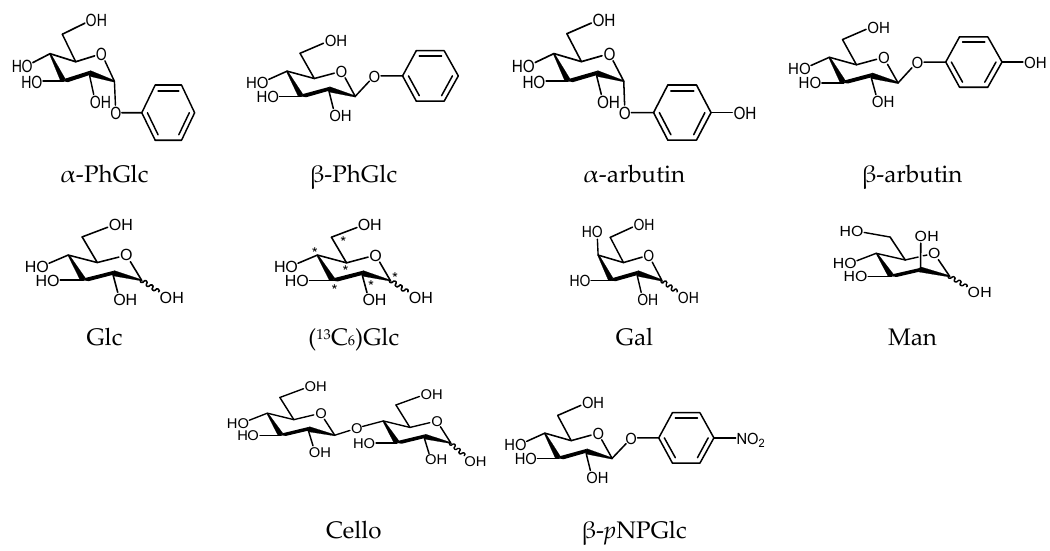
Figure 1. Carbohydrate derivatives used for DOSY analysis on anomer isomers. 2.1. DOSY Separation of the α - and β -Anomeric Isomers of Glycopyranosides The DOSY separation of the anomeric isomers in a mixture of 10 mM phenyl β -glucopyranoside ( β -PhGlc) and 10 mM phenyl α -glucopyranoside ( α -PhGlc) was firstly investigated. Figure 2 shows the DOSY spectrum of the mixture of α -PhGlc and β -PhGlc in D 2 O at 30 °C, together with the individual 1 H NMR spectra of β -PhGlc and α -PhGlc in D 2 O. In the DOSY spectrum, two different species with diffusion coefficients ( D ) of 5.9 × 10 − 10 m 2 ·s − 1 and 5.6 × 10 − 10 m 2 ·s − 1 could be identified, whose resonances corresponded to the 1 H NMR spectrum of β -PhGlc and α -PhGlc, respectively. It was thereby found that the apparent difference between the diffusion coefficients of β -PhGlc and α -PhGlc was